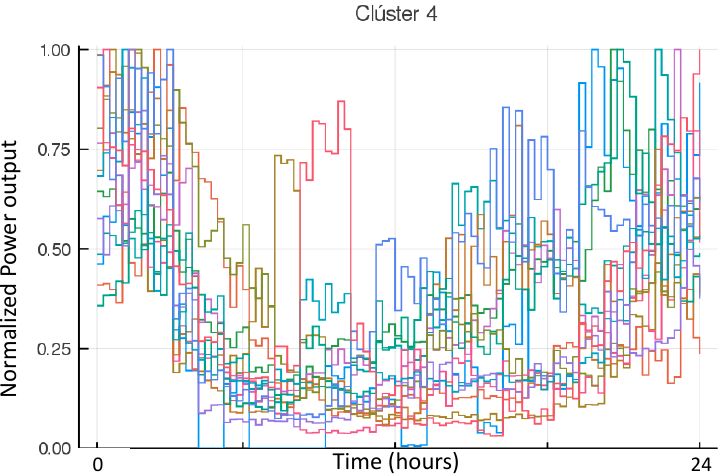
Figure 9. Data of 362 actual distribution customers from Santiago, Chile. Cluster 4.